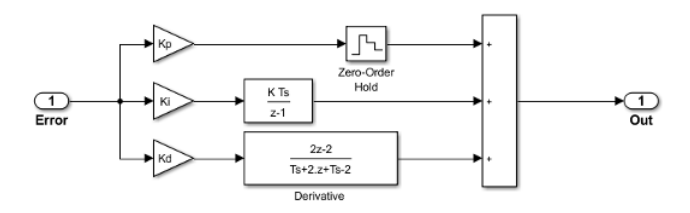
Fig. 6. PID correction